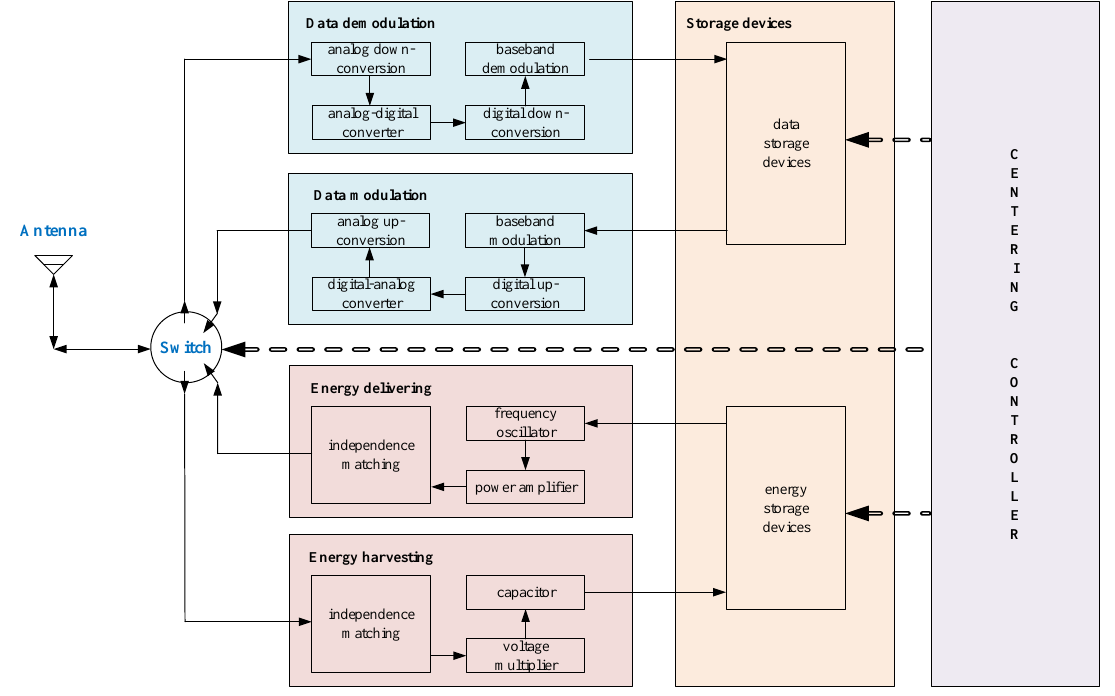
Figure 2. The structure of a power and data beacon